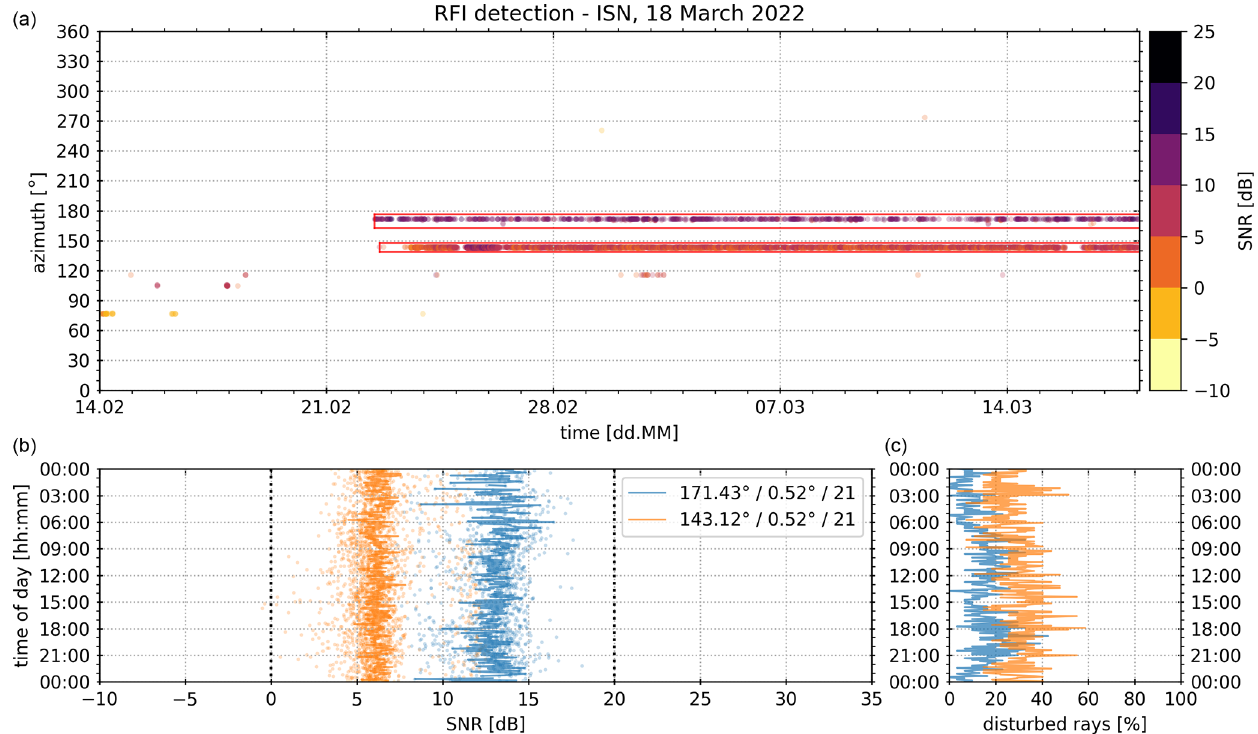
Figure 3. The operational RFI analysis from 18 March 2022. Included are disturbed rays from the previous 30d. The top panel shows each disturbed ray as a dot in the scatter plot (colours of dots depict median SNR). All detected RFI sources with an RFI severity greater than or equal to zero are marked with a red box. At the bottom additional properties of each severe RFI are displayed. The data in both bottom panels are accumulated into 5min bins according to the time of day ( y axis). The bottom left panel shows SNR, and the bottom right panel shows the fraction of disturbed rays. Dashed lines in the bottom left panel correspond to RFI class SNR limits (persistent and strong). The mean azimuth, mean elevation and RFI severity of each severe RFI are displayed within the